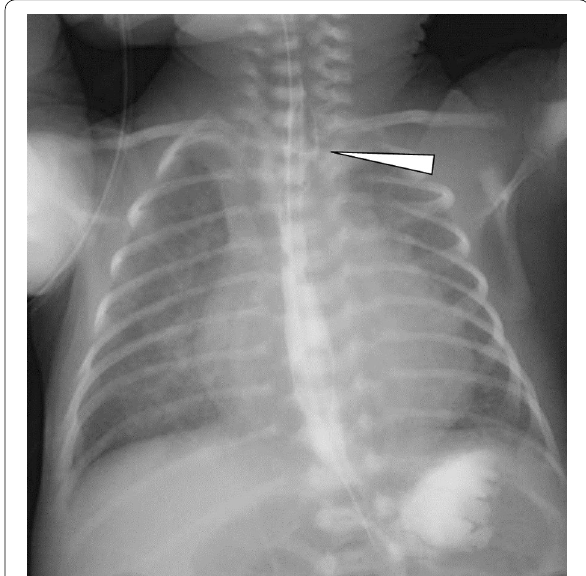
Fig. 3 Postoperative esophagogram, showing anastomosis of the esophagus (white arrowhead). There was no noted stenosis at the anastomosis